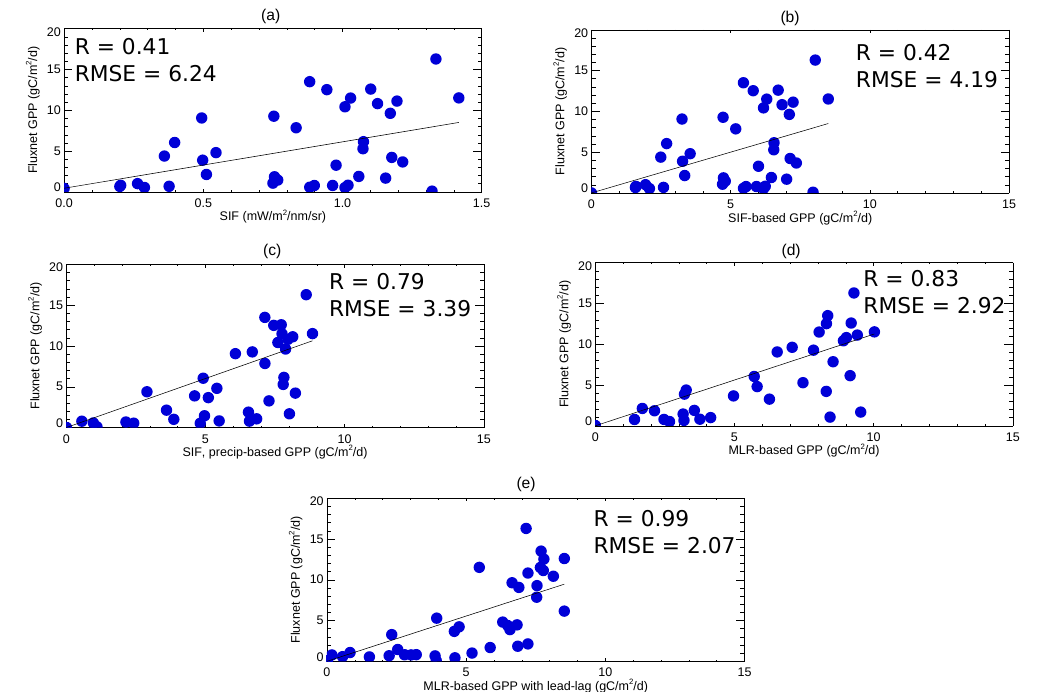
Figure 9. Relationship of mean monthly GPP (gC/m 2 /day) measured at US-Twt FLUXNET station with rice as a characteristic plant species (Table 1) and ( a ) GOME-2 SIF; ( b ) SIF-based GPP; ( c ) SIF- and precipitation-based GPP; ( d ) MLR-based GPP (SIF, precipitation, soil moisture as predictors); ( e ) MLR-based GPP with lead–lag. The Spearman’s correlation coefficient R and root-mean-square error RMSE (gC/m 2 /day) are